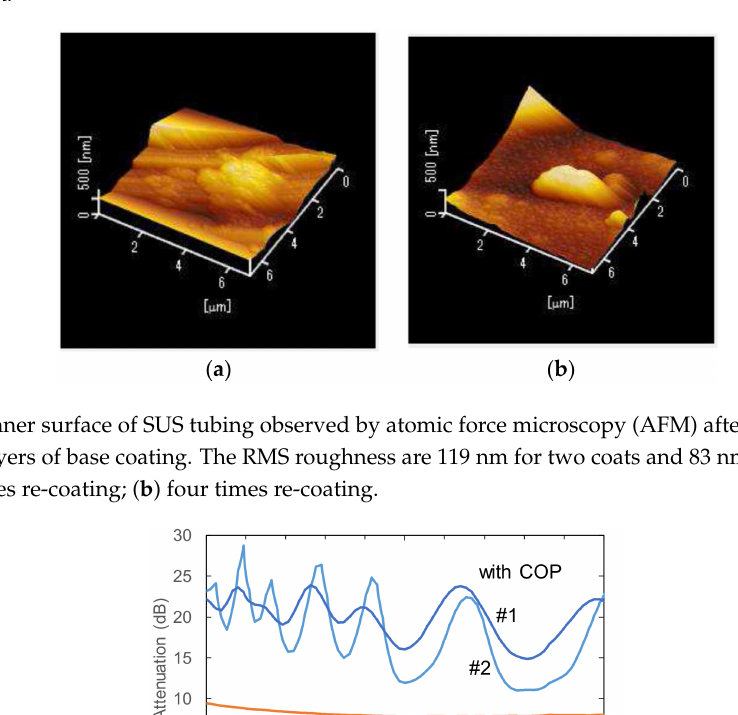
Figure 2. Surface roughness of inner surface of SUS tubing as a function of number of coats of the acrylic resin.